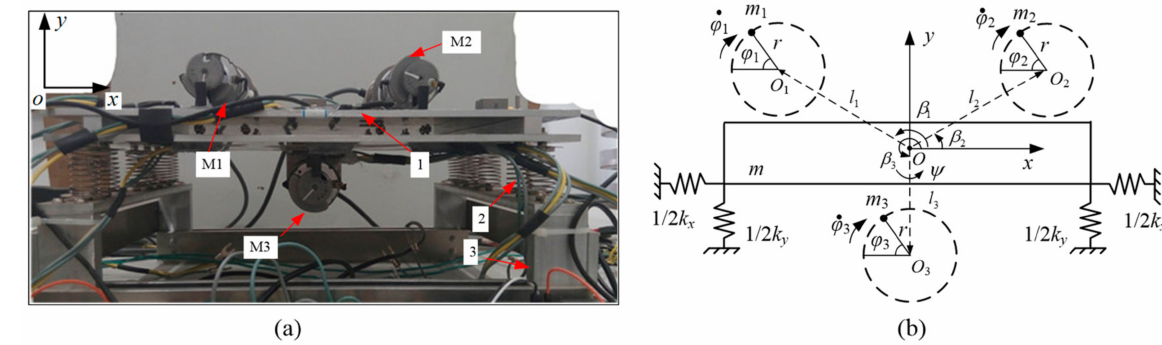
Figure 1. The vibration machine is excited by three eccentric rotors (ERs): ( a ) the vibration machine; ( b ) the dynamic